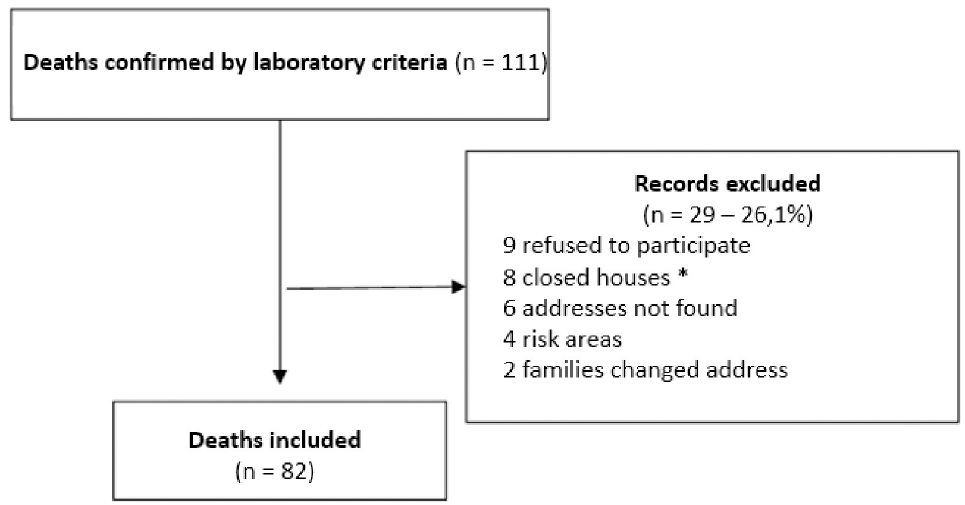
Fig 2. Flowchart of cases investigated during the chikungunya epidemic in the city of Fortaleza in 2017. � After 4 attempts at different times.